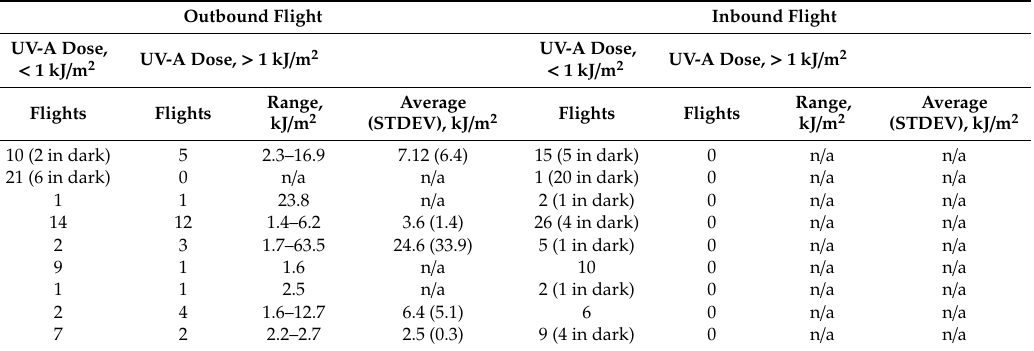
Table 2. Summary of the afternoon departure flights (departure time after 12 noon UTC)